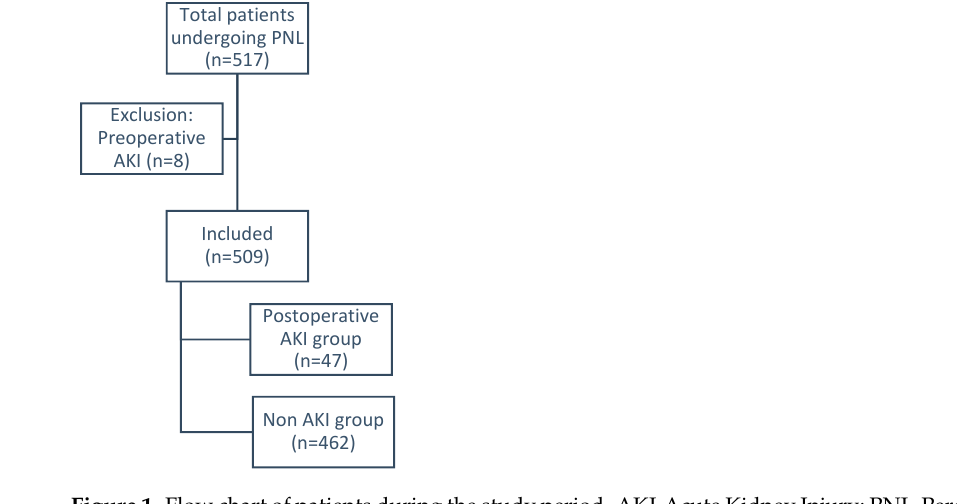
Figure 1. Flow chart of patients during the study period. AKI-Acute Kidney Injury; PNL-Percutaneous Nephrolithotomy. Details of patient demographics and stone characteristics with the univariate analysis for independent predictive factors for development of postoperative AKI are mentioned in Tables 2–4. Those with AKI were older (mean age 54.8 ± 13.9 vs. 47.4 ± 13.7 years, OR = 1.041, 95% CI = 1.017–1.066, p = 0.001), significantly more likely to have hypertension (51.1% vs. 25.5%, OR = 3.042, 95% CI = 1.655–5.593, p = 0.0002), diabetes mellitus (29.8% vs. 17.3%, OR = 2.026, 95% CI = 1.037–3.959, p = 0.036), have received ACE inhibitors (10.6% vs. 3.7%, OR = 3.116, 95% CI = 1.095–8.871, p = 0.036), have lower preoperative hemoglobin (12.6 ± 2.25 vs. 13.3 ± 1.86, p = 0.013) and have higher serum uric acid (5.2 ± 1.46 vs. 3.9 ± 1.44, OR = 1.758, 95% CI = 1.336–2.315, p = 0.00001) as compared to those without AKI. Stone volume (mm 3 ) (2117.9 (761–12,452) vs. 825 (503–1573) p = 0.0000001), stone density (817.4 ± 439.76 vs. 985.2 ± 253.98, p = 0.0001) and number of staghorn stones (12.8% vs. 3.2%, OR = 4.361, 95% CI = 1.605–11.846, p = 0.008) were significant higher in those with AKI. Table 2. Patient characteristics, preoperative laboratory values and stone characteristics. Variables